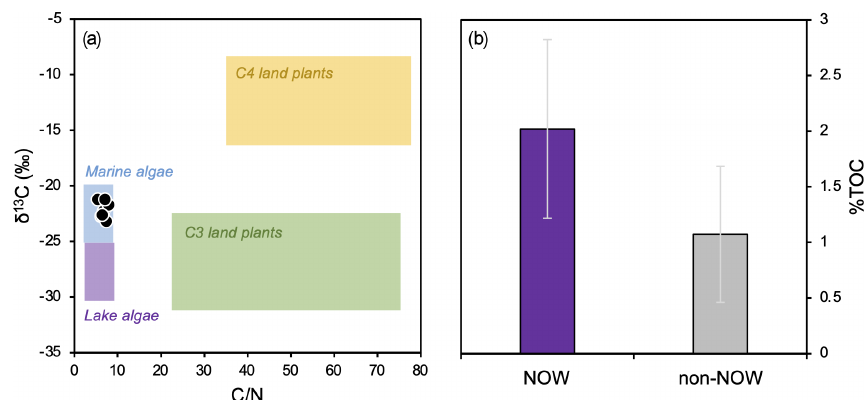
Figure 3. Bulk geochemistry data for this study’s dataset ( n = 9, Table 1). (a) Organic matter provenance based on bulk C / N and δ 13 C values, where reference values for four endmembers are after Meyers (1994), and (b) average %TOC and standard deviation for sites in the NOW (purple, n = 5) and sites outside the NOW (gray, n =